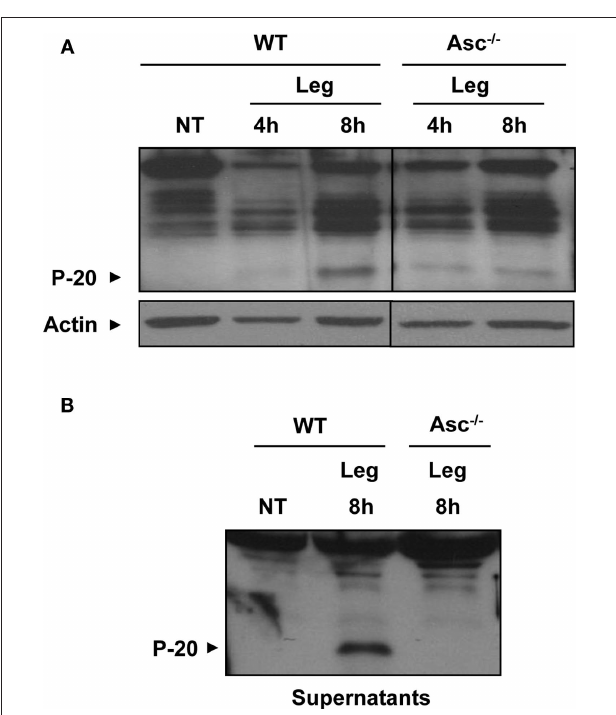
Figure 3 | A fraction of caspase-1 is activated in the cytosol of murine macrophages lacking Asc. (A) WT and Asc − / − mouse macrophages were either not treated (NT) or infected with L. pneumophila (Leg) at MOI = 0.5 for 4 and 8 h. Then active caspase-1 (p-20) was detected in the cell extracts (A) and the supernatants (B) by Western blotting. Actin was used as a loading